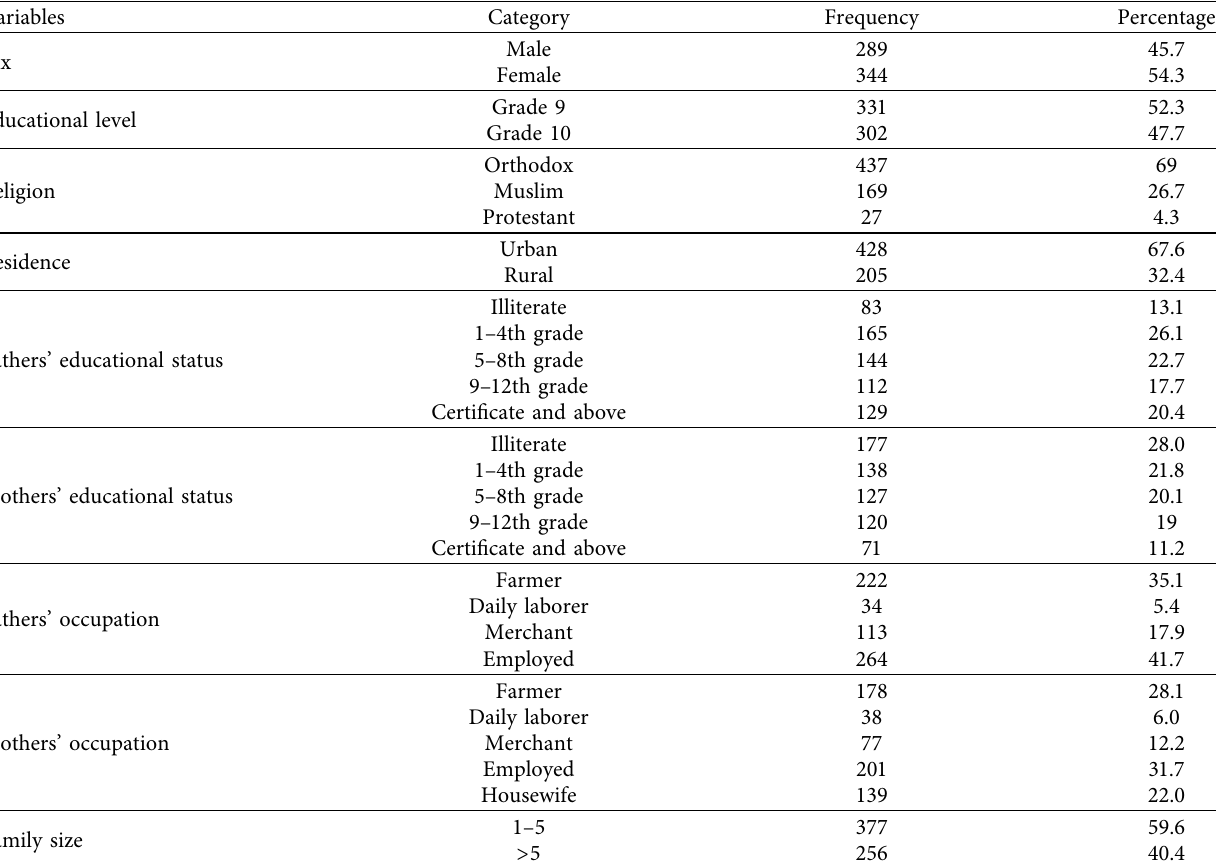
Table 1: Sociodemographic characteristics of adolescents aged 15–19 years at governmental high schools of Aksum town, Tigray, Ethiopia, in 2019 ( n �